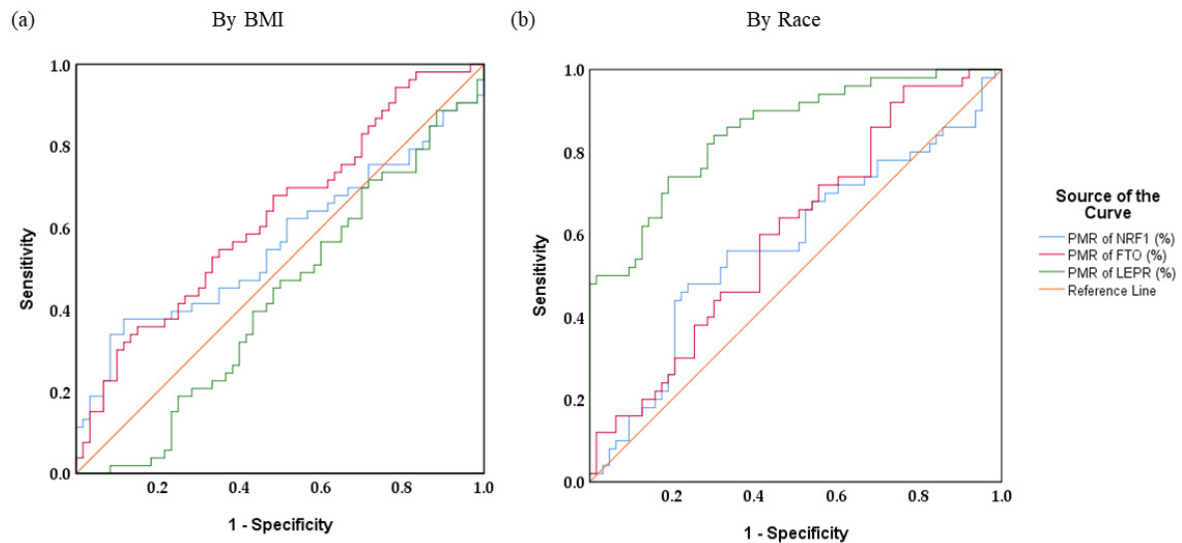
Figure 5. Receiver operating characteristic (ROC) curves for NRF1 , FTO , and LEPR based upon ( a ) BMI and ( b ) Race. The diagonal line is the reference line.